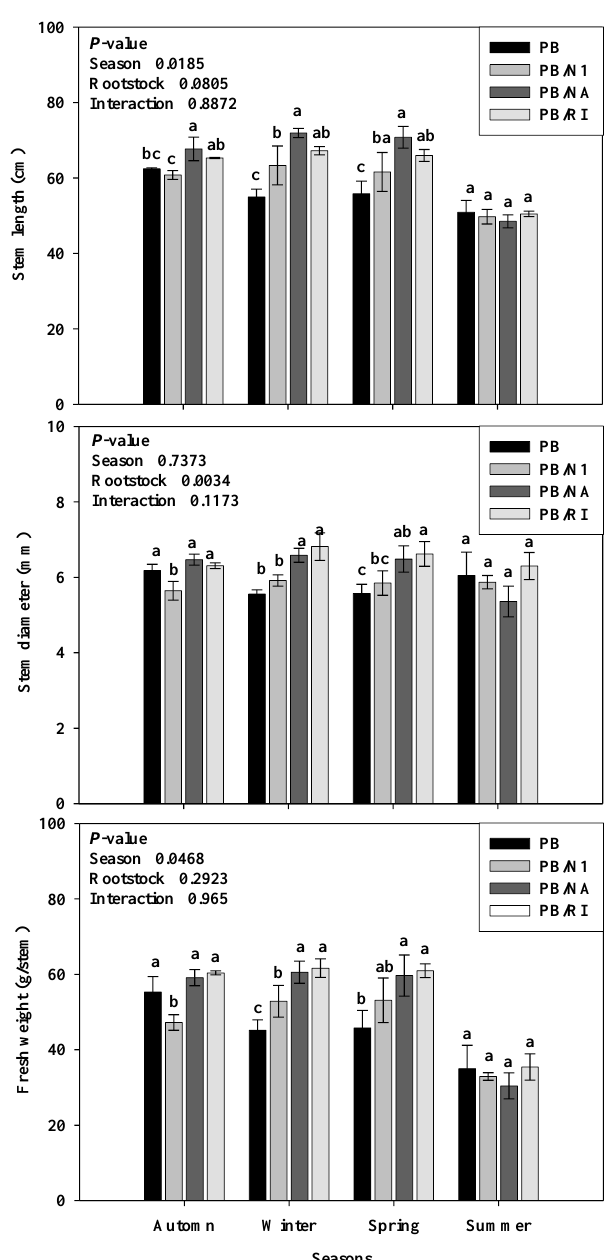
Figure 9. The stem length, stem diameter, and fresh weight for scion cut rose Rosa hybrida cv. Pink Beauty (PB), rootstock of Rosa multiflora cv. Hort No 1 (N1), rootstock of Rosa canina cv. Natal brier (NA), rootstock of Rosa indica cv. Major (RI), PB grafted onto N1 (PB/N1), PB grafted onto NA (PB/NA), PB grafted onto RI (PB/RI) in four seasons. Vertical bars are standard deviations ( n = 15). Small letters at the data points indicate mean separation between the values by Duncan’s multiple test at p = 0.05. Values were determined by two-way ANOVA.